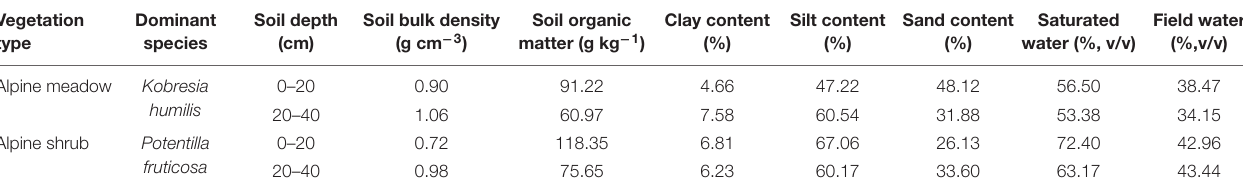
FIGURE 1 | The location of study area (I) , alpine meadow (II) , and alpine shrub (III) . TABLE 1 | Vegetation and soil characteristics at 0–40 cm across two vegetation types in the study